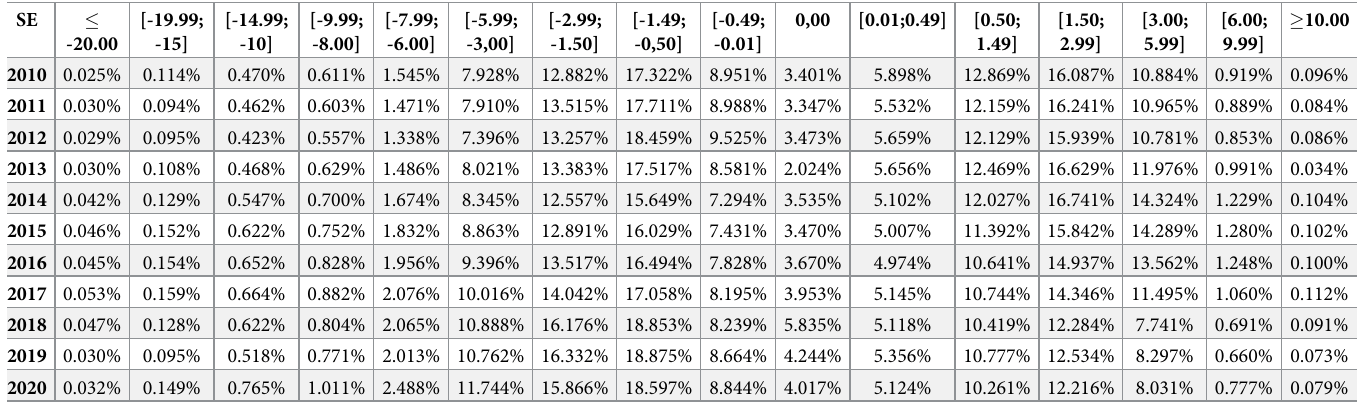
Table 1. Total percentage values according 14 spherical equivalent (SE) ranges for the non-progressive/single vison prescriptions group. SE � [-19.99; -20.00